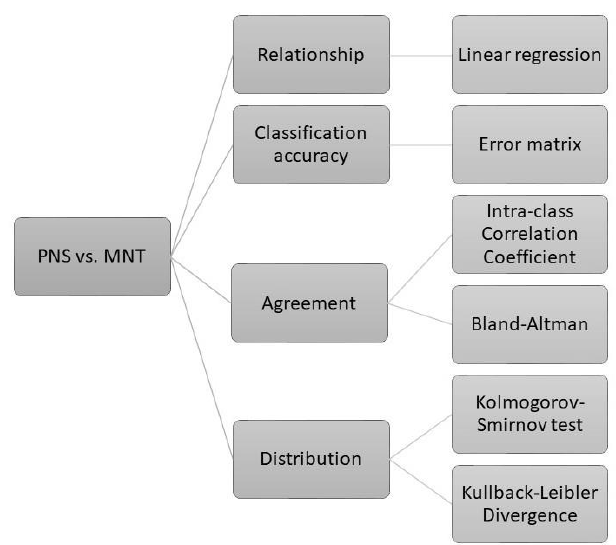
Figure 1. Flowchart of the statistical methods. Comparison between pseudotype neutralising titres (PNT) and live virus micro-neutralisation titres (MNT) was conducted via different approaches, which enabled us to elucidate the overall convergence of the PNT and MNT results.